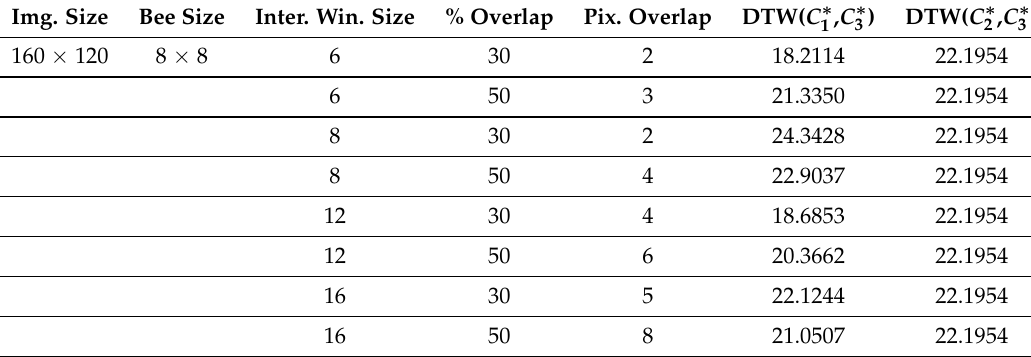
Table A13. DTW values for MT _ Vid . mp 4 with image size of 160 × 120; C ∗ and C ∗ is Human Count (ground truth). 3 Img.